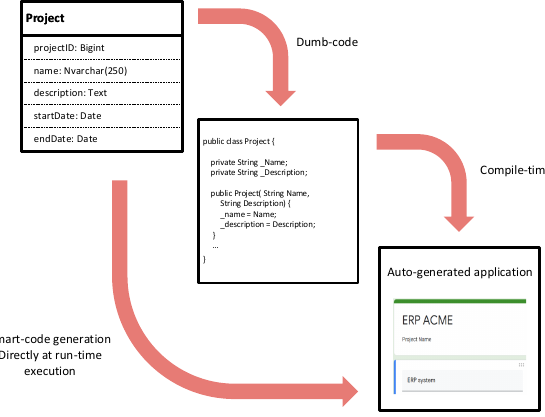
Figure 1. Dumb-code vs. smart-code generation